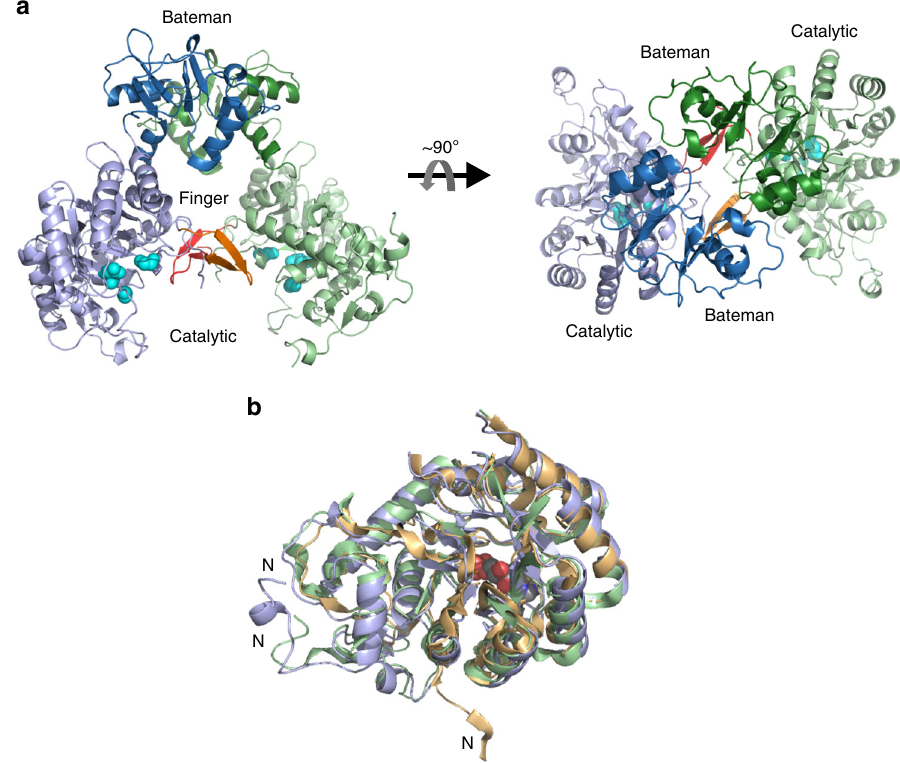
Fig. 4 Structure of TbIMPDH and catalytic domain comparison. a Side and top view on the two monomers of TbIMPDH (green and blue), each consisting of the catalytic (light colors) and the regulatory Bateman domain (dark colors), that form a dimer in the ASU. The fi nger domains (red and orange) as well as the residues Asp358, Gly360, and Gly381 that are usually involved in hydrogen bond formation with the ribose and the phosphate moiety of IMP (cyan, in sphere representation) are highlighted. b Superposition of the catalytic domain of TbIMPDH (residues 8 – 120 and 237 – 514, blue) with corresponding residues of human IMPDH1 (PDB 1JCN, green), in complex with the substrate analog 6-chloropurine riboside 5 ′ -monophosphate (CPR, in sphere representation) to locate the substrate binding site, and of the bacterial IMPDH from P. aeruginosa (PDB 1DQW, yellow). N